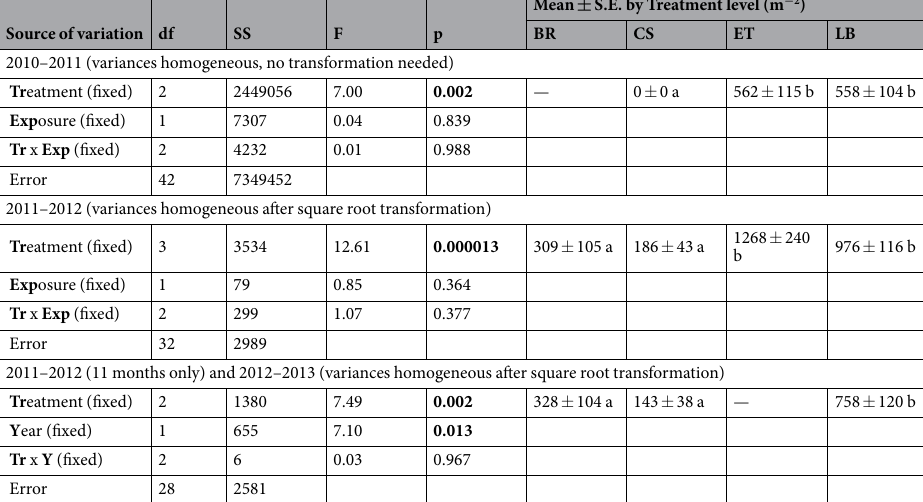
echinata , with only 12 ± 4% fraction of Styela spp.) was exceptionally high and variable on red algae blades (where